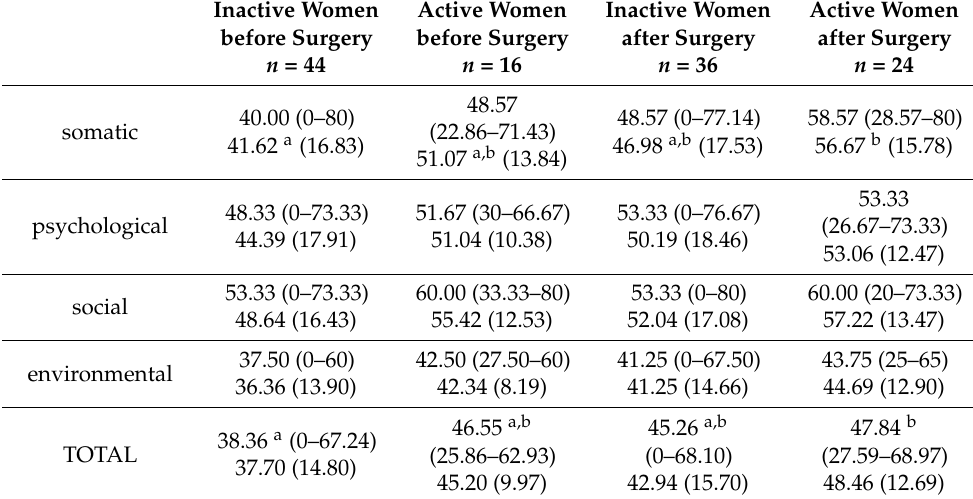
Table 4. Domain scores of the WHOQOL-BREF questionnaire from physically inactive and physically active women before and after surgery.